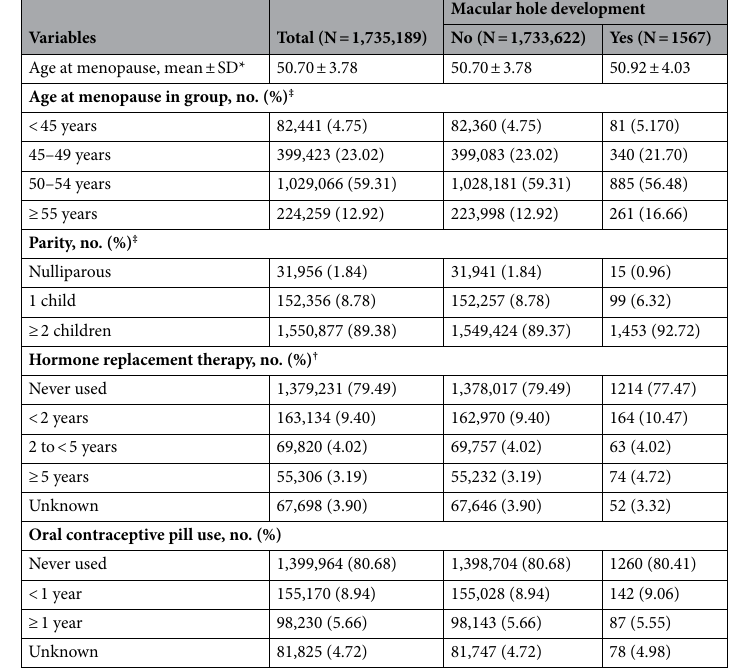
Table 4. Baseline characteristics of the study subjects for Analysis 2. SD standard deviation, Q quartile. *p-value < 0.05; † p-value < 0.01; ‡ p-value <